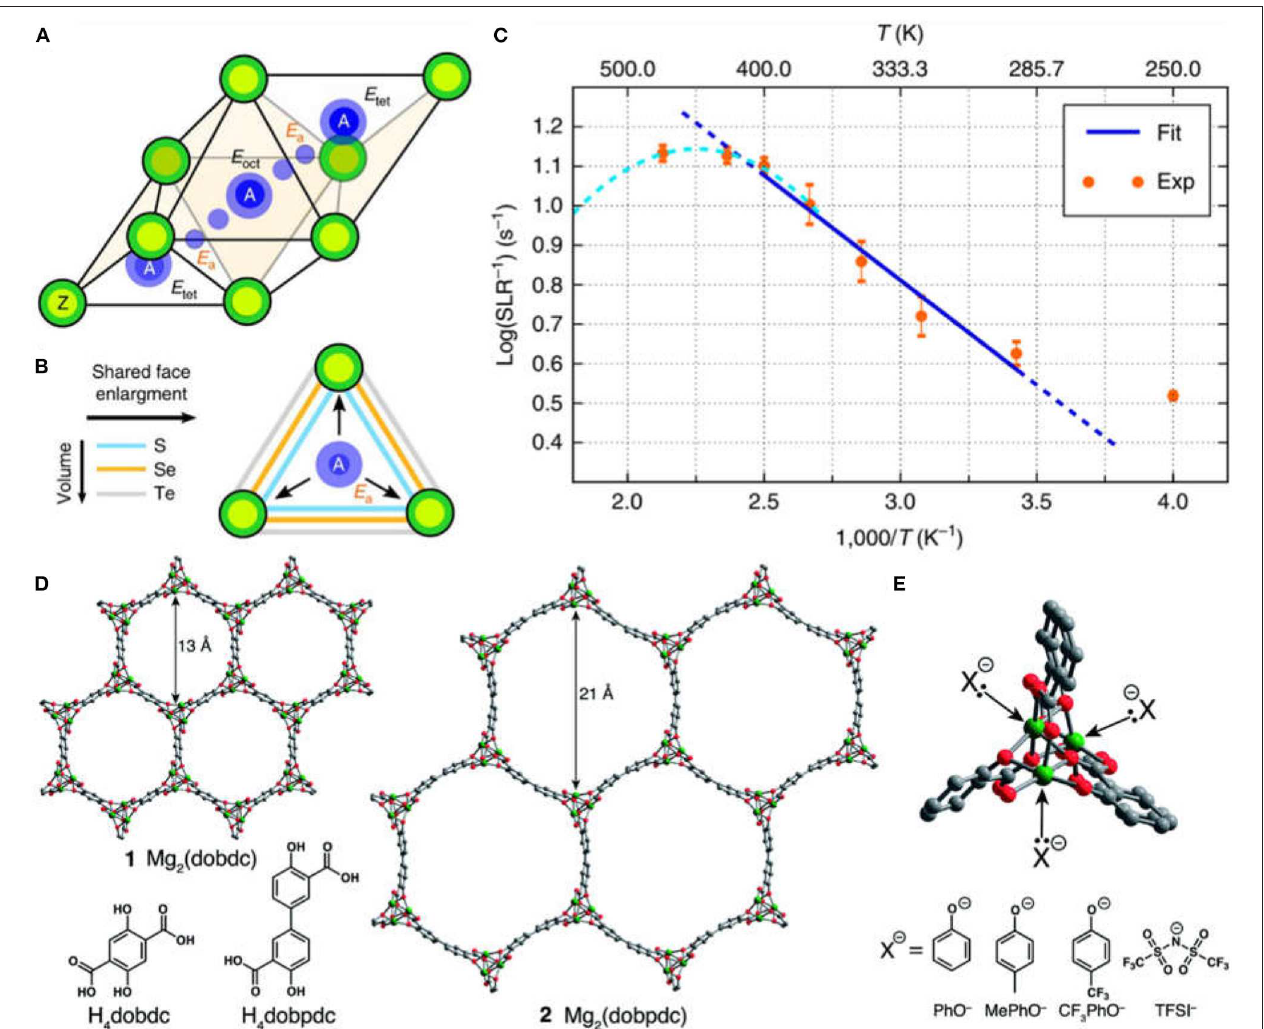
FIGURE 1 | Tet - oct - tet migration path in the AX 2 Z 4 framework, with energy of the tet , oct , and transition sites indicated by E tet , E oct , E a , respectively (Ea corresponds to the migration energy) (A) ; effect of the anion size on the shared (triangular) face between tet and oct sites (B) and 25 Mg static variable temperature spin lattice relaxation data collected at 7.02T as function of temperature and Arrhenius fit (C) . Reproduced from Canepa et al. (2017), licensed under CC BY 4.0. structures of the metal–organic frameworks Mg 2 (dobdc) ( 1 ) and Mg 2 (dobpdc) ( 2 ), as viewed along the c -axis (D) ; a close-up of the open coordination sites at the vertices of the pore that interact with nucleophilic guest species: PhO − = phenolate, MePhO − = 4-methylphenolate, CF 3 PhO − = 4-trifluoromethylphenolate, and TFSI − = bis(trifluoromethanesulfonyl)imide (E) . Reproduced with permission from Aubrey et al. (2014), Copyright 2014, Royal Society of